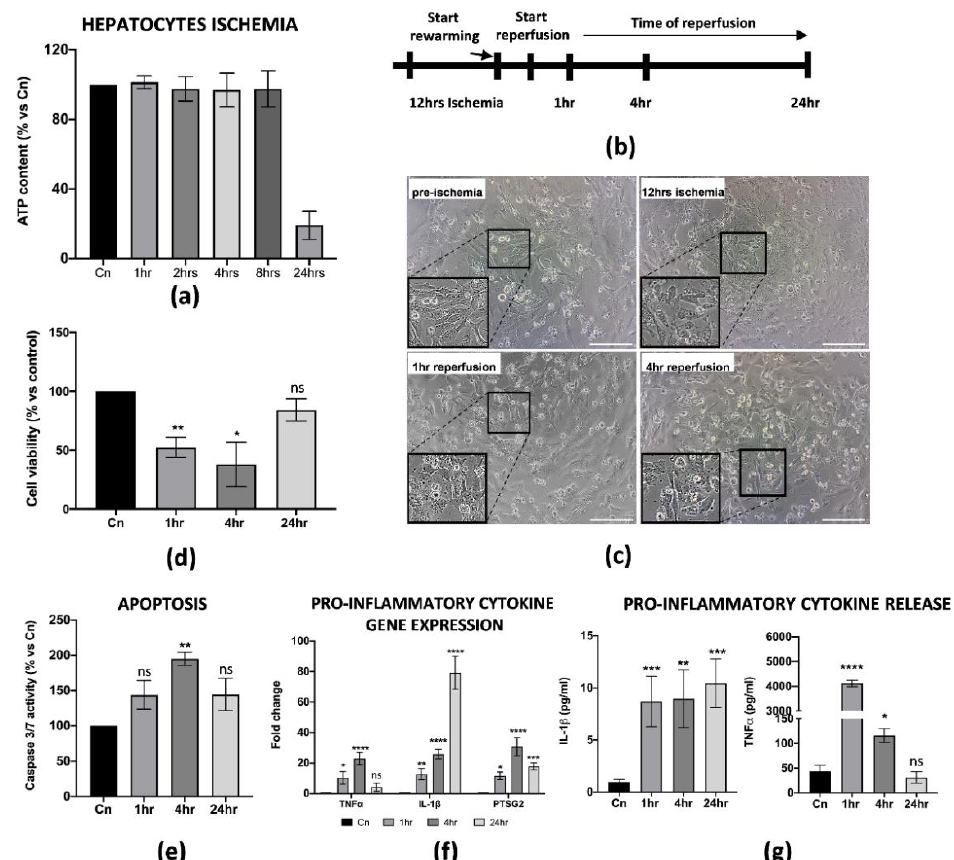
Figure 3. In vitro IRI on THLE-2 hepatocytes induced inflammation and apoptosis. ( a ) Intracellular ATP quantification in THLE-2 subjected to cold ischemia at different timepoints. Data are represented as % of ATP in the experimental conditions vs. control (Cn) not induced to ischemia ( n = 4). ( b ) Schematic representation of the IRI protocol applied to THLE-2 hepatocytes. ( c ) Image representation of M1-like macrophages challenged with full IRI protocol. Scale bar 75 µ m. ( d ) Cell viability analysis of THLE-2 reperfused at different timepoints. Data are represented as % vs. control (mean ± std). Statistical significance has been calculated via ordinary one-way ANOVA (Dunnet’s multiple comparisons test, n = 3, * = p < 0.05; ** = p < 0.005; ns = not significant). ( e ) Caspase 3/7 analysis in THLE-2 hepatocytes after reperfusion at the timepoints indicated. Data are represented % vs. control (mean ± std). Statistical significance has been calculated via ordinary one-way ANOVA (Dunnet’s multiple comparisons test, n = 3, ** = p < 0.005; ns = not significant). ( f ) Gene expression analysis of pro-inflammatory genes in reperfused THLE-2 hepatocytes at different timepoints. The comparison has been conducted by using the ∆∆ CT method and normalized to GAPDH transcript. Statistical significance has been calculated via ordinary one-way ANOVA (Dunnet’s multiple com- parisons test, n = 3, * = p < 0.05; *** = p < 0.0005; **** = p < 0.0001; ns = not significant). ( g ) IL-1 β and TNF α protein quantification in the conditioned medium of reperfused THLE-2 hepatocytes at different timepoints. Protein concentration has been calculated according to the standard curve of each ELISA assay ( n = 3). Statistical significance has been calculated via ordinary one-way ANOVA (Dunnet’s multiple comparisons test, n = 3, * = p < 0.05; ** = p < 0.005; *** = p < 0.0005; **** = p < 0.0001; ns = not